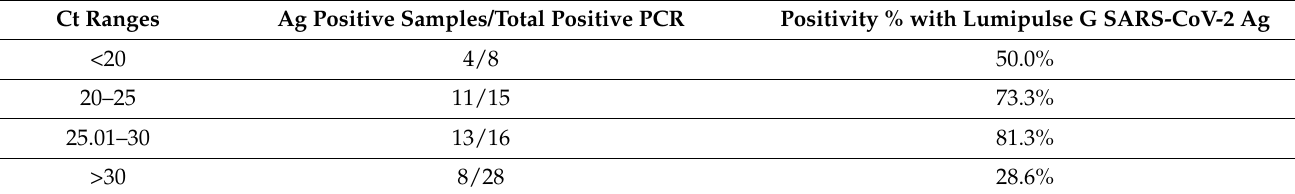
Table 4. Percentage of positivity of frozen saliva samples according to the Ct range of the molecular test. Ct Ranges